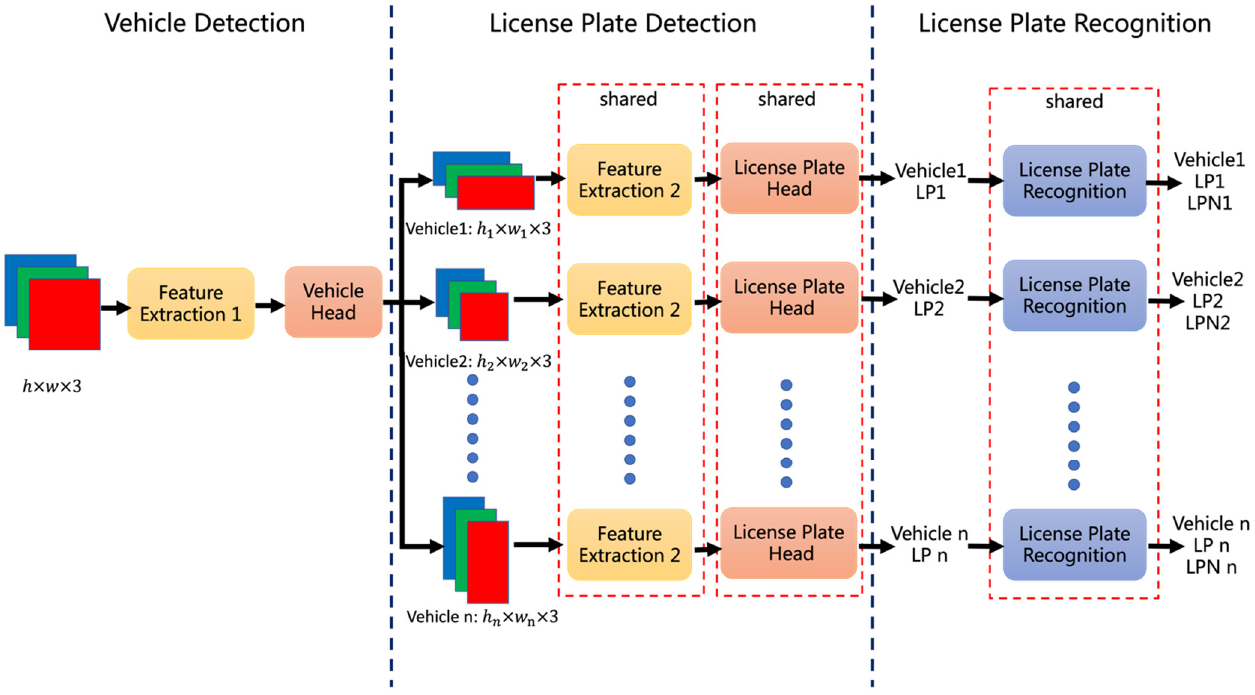
Figure 3. The structure of VLN.